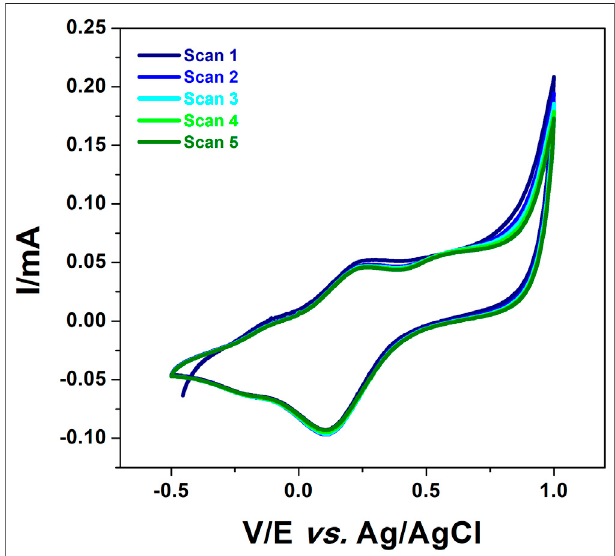
FIGURE 2 | CV of poly 1,8-DAN/f-MWCNT/CPE in 0.1 M HCl at a scan rate of 50 mV/s.